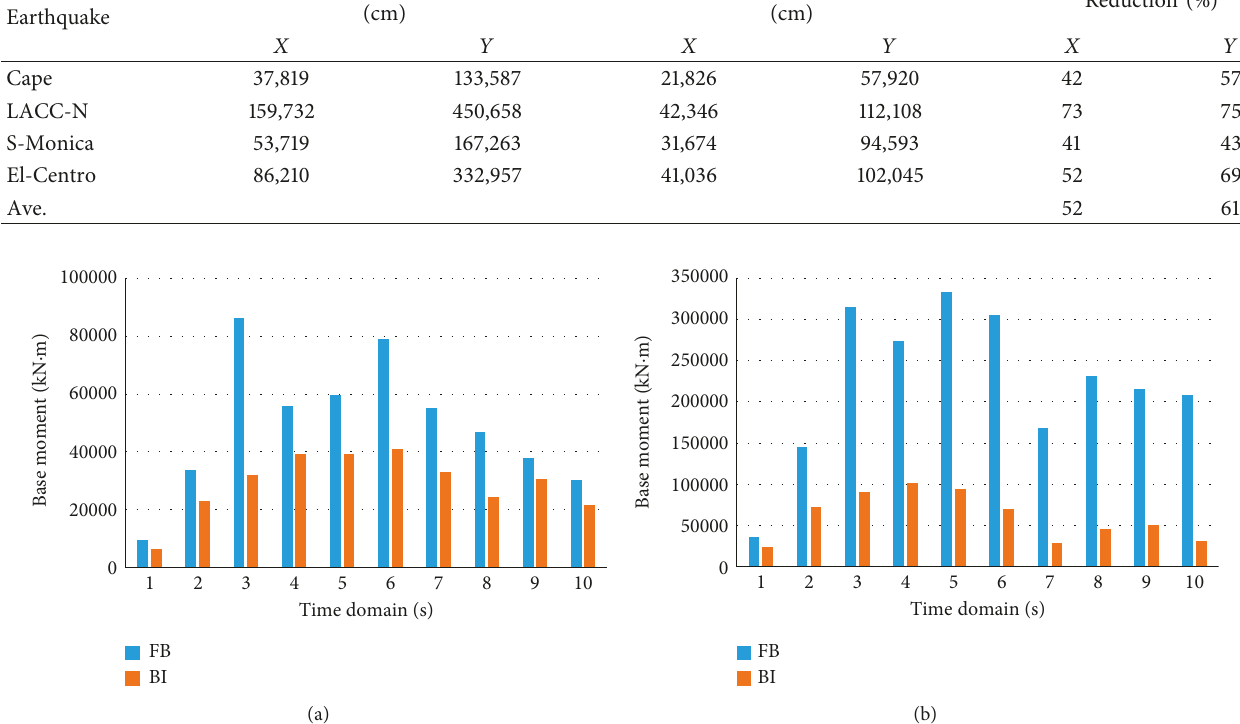
FBI shorter building disp.